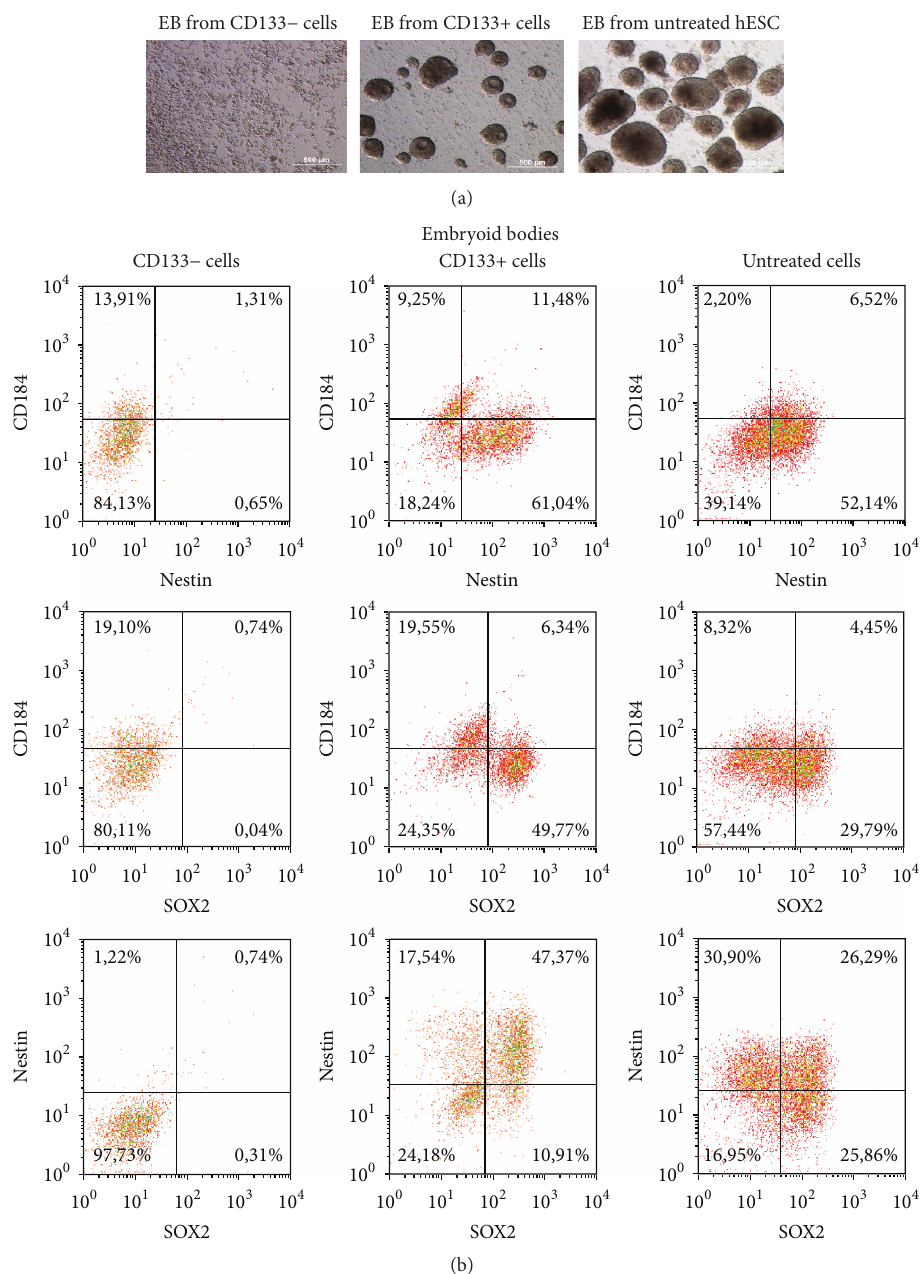
found in our study indicates that the ratio of the number of CD133+OCT4+ cells to CD133 − OCT4 − cells before differen- tiation is a predictive marker for characterizing the ability of hES cells to form